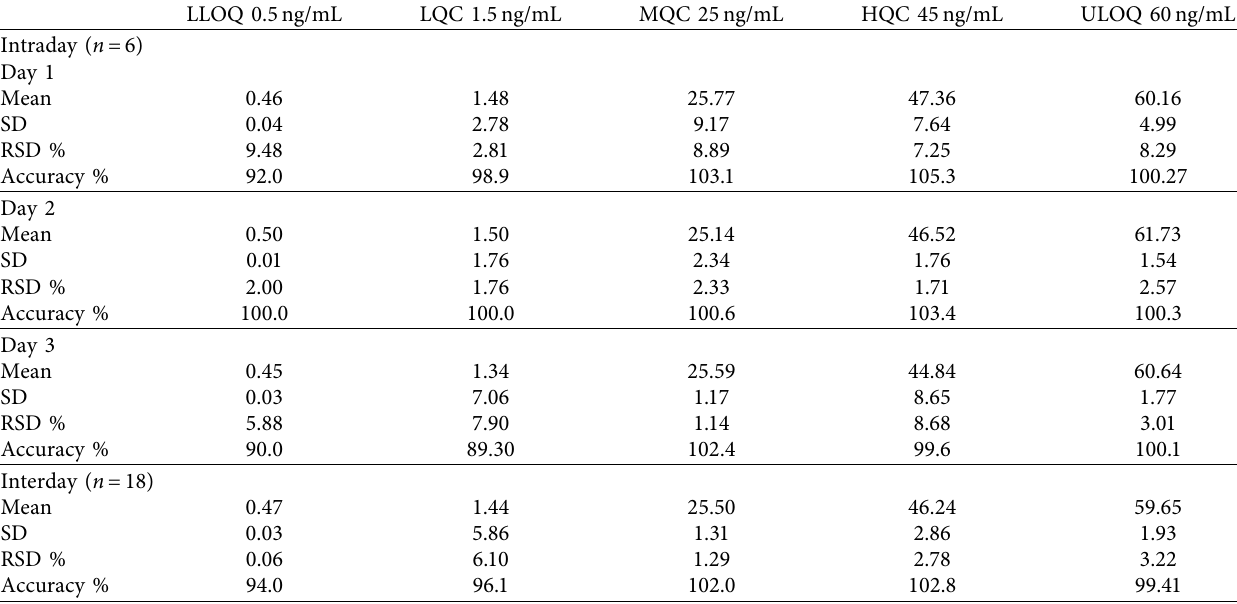
Figure 3: Chromatogram for (a) blank plasma with no interfering peaks at the retention time of the analytes were observed; (b) blank plasma spiked with vardenafil at LLOQ 0.5ng/mL and IS at 40ng/mL; (c) blank plasma spiked with vardenafil at ULOQ 60ng/mL and IS at 40ng/mL; and (d) plasma sample in rabbit 1.5h after drug administration with a concentration of 44.95ng/mL. Table 2: Imprecision and accuracy for the determination of vardenafil in